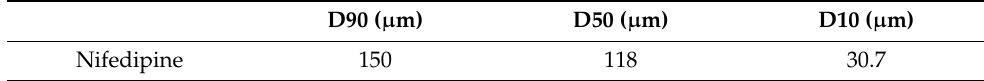
Table 3. Estimated content of each component in Adalat ® -L.